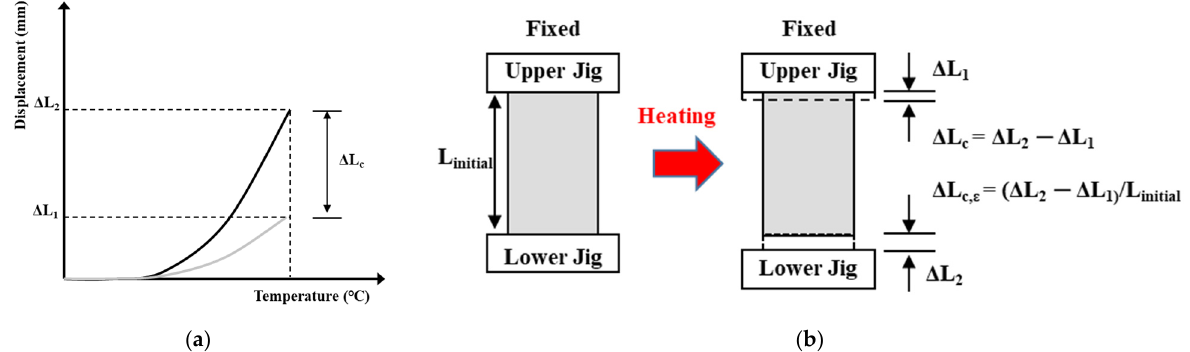
Figure 5. Test method for determining the thermal strain of concrete with loading and heating. ( a ) total deformation. ( b ) total strain.